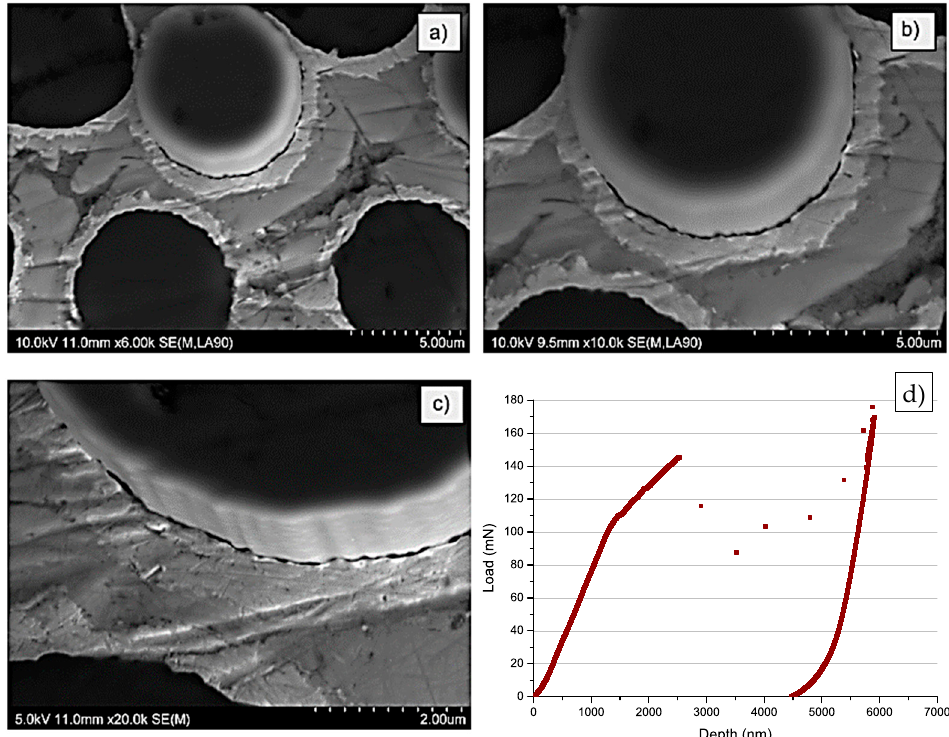
Figure 8. Bottom surface SEM images of the MMC3 sample after push-out tests: ( a,b ) BSE mode; ( c ) SE mode; ( d ) typical curve obtained during push out tests with MMC3 sample.